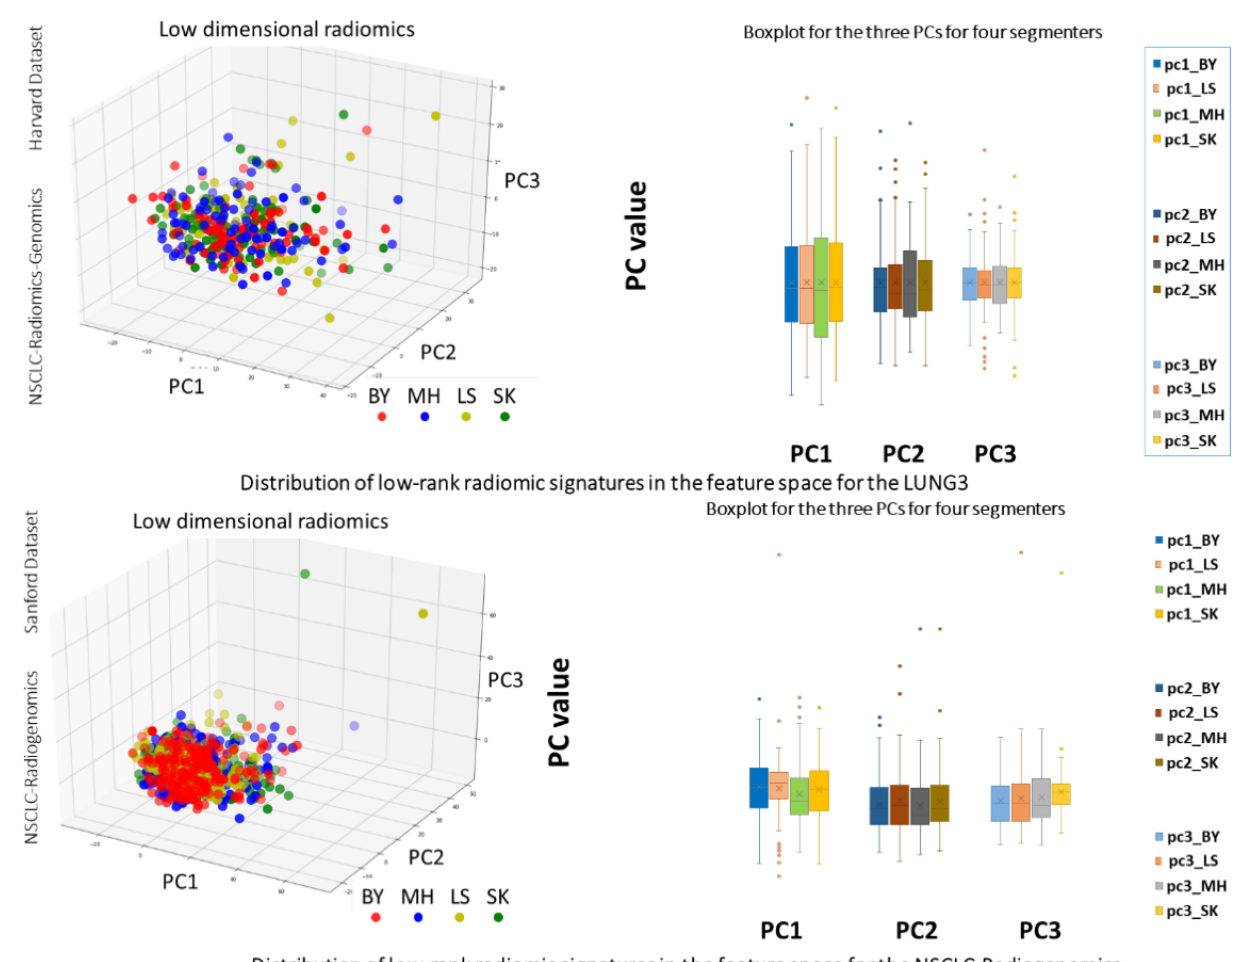
Figure 3. Two visual comparisons of low-rank radiomics representation with their boxplots relation for labels provided by BY, LS, MH, and SK for two different NSCLC Radiogenomics datasets. The Dice coefficients for the 3D masks for Harvard NSCLC-Radiomics-Genomics and Stanford NSCLC-Radiogenomics for each segmenter (Table 3) was 0.894 (STD: ±0.25) − 0.71 (STD: ±0.28) for the image scientist (BY)—Reference Standard (SK), 0.82 (STD: ±0.14) − 0.80 (STD: ±0.27) between the medical student (LS)—Reference Standard (SK), and 0.839 (STD: ±0.20) − 0.83 (STD: ±0.23) between the radiology trainee (MH)—Reference Standard (SK),